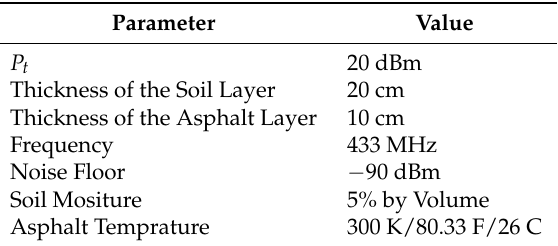
Figure 3. The propagation loss in the asphalt medium with change in layer thickness. Table 1. Model evaluation parameters.